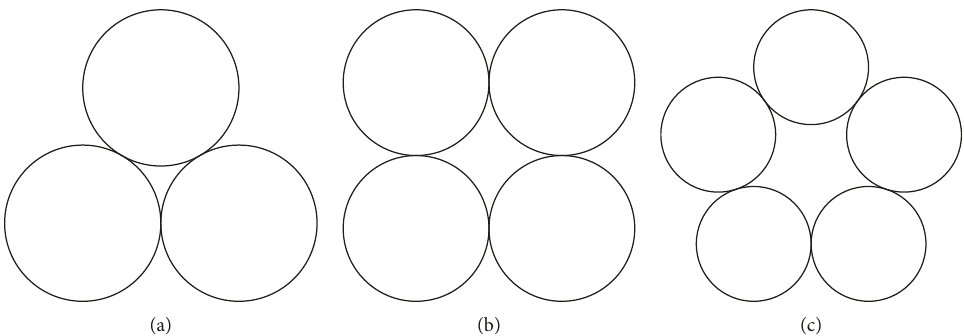
Figure 1: Cross section of different particle systems. (a)–(c) show different cross sections with various particle combinations. (a) Cross section with three particles. (b) Cross section with four particles. (c) Cross section with five particles.